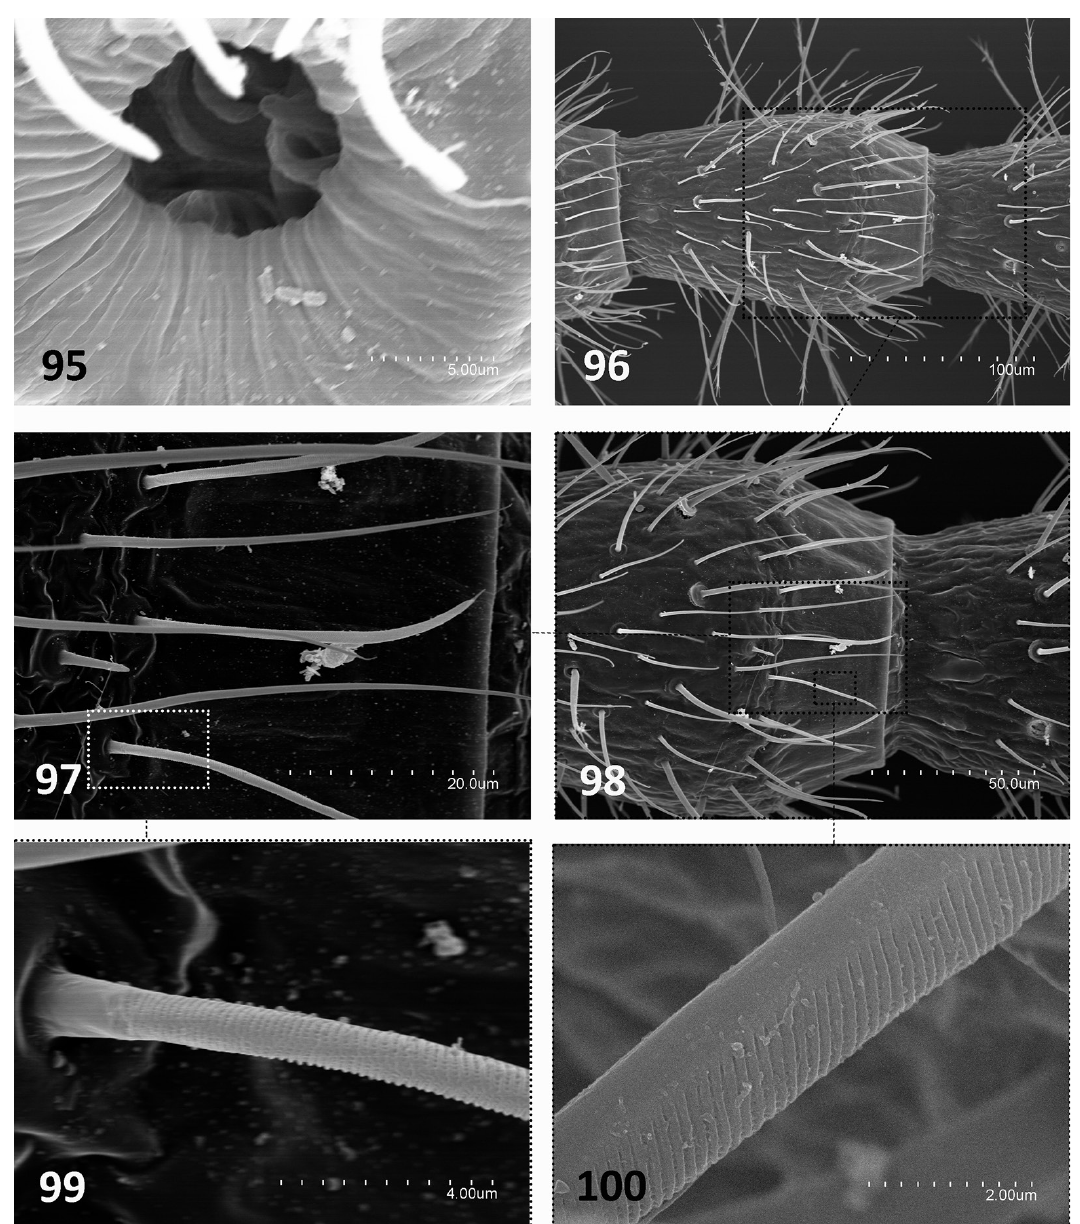
Figs 95–100. Plusiocampa ( Plusiocampa ) lagari Sendra & Condé, 1987, from Chorros Cave, Riopar, Albacete, Spain (Coll. AS). 95 . Cupuliform organ. 96 . Medial antennomere. 97 . Gouge and coniform sensilla. 98 . Medial antennomere, detail with gouge and coniform sensilla. 99 . Base of gouge sensillum, detail. 100 . Medial portion of gouge sensillum,